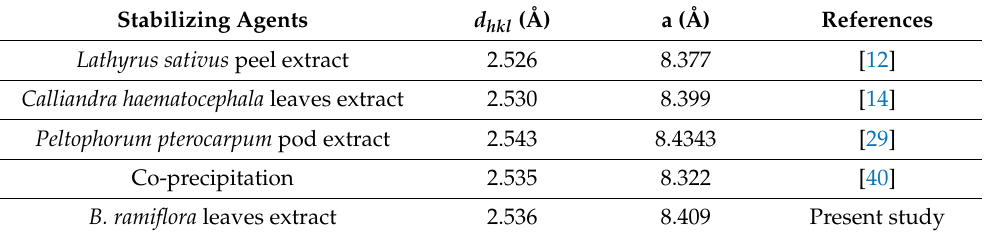
Table 1. Comparison of Miller indices for Fe 3 O 4 NPs with other similar studies.